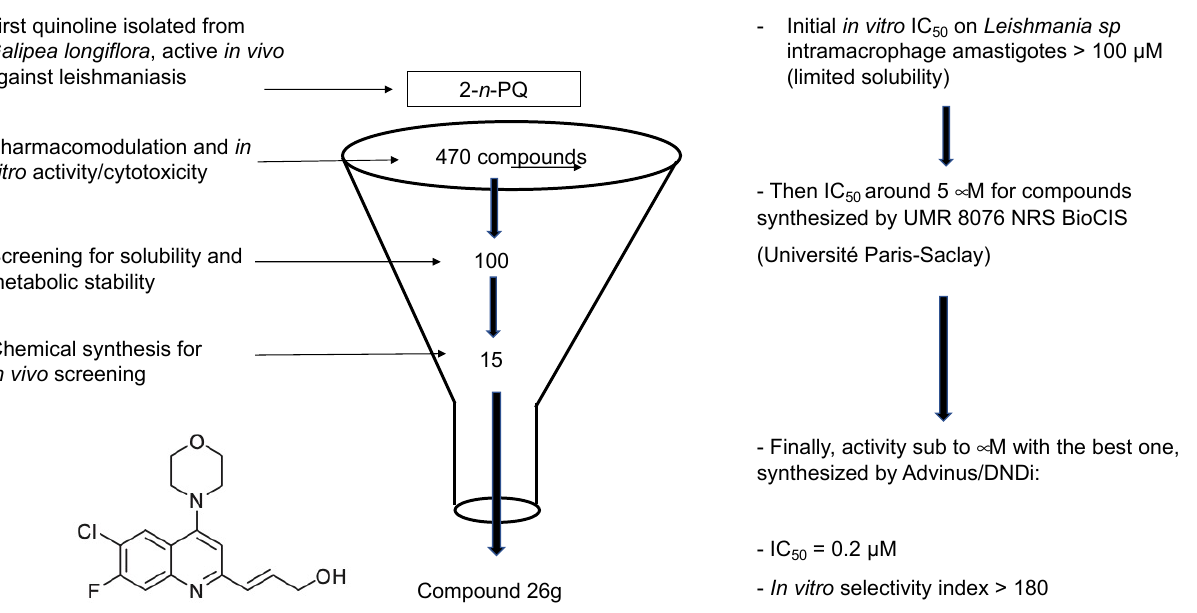
Figure 5. Workflow for selecting the most promising compound.